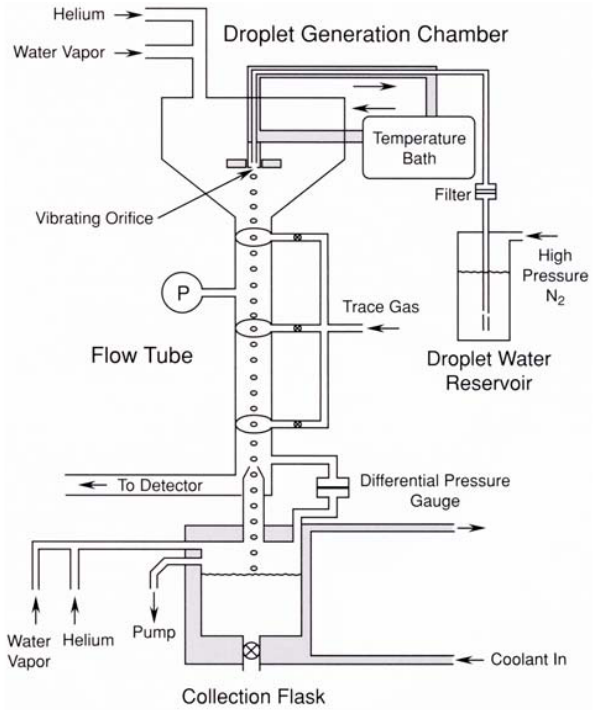
Fig. 2. Schematic diagram of typical droplet train flow reactor for measurement of uptake coefficients of trace gases into liquids (adapted from Jayne et al., 1992).570 571